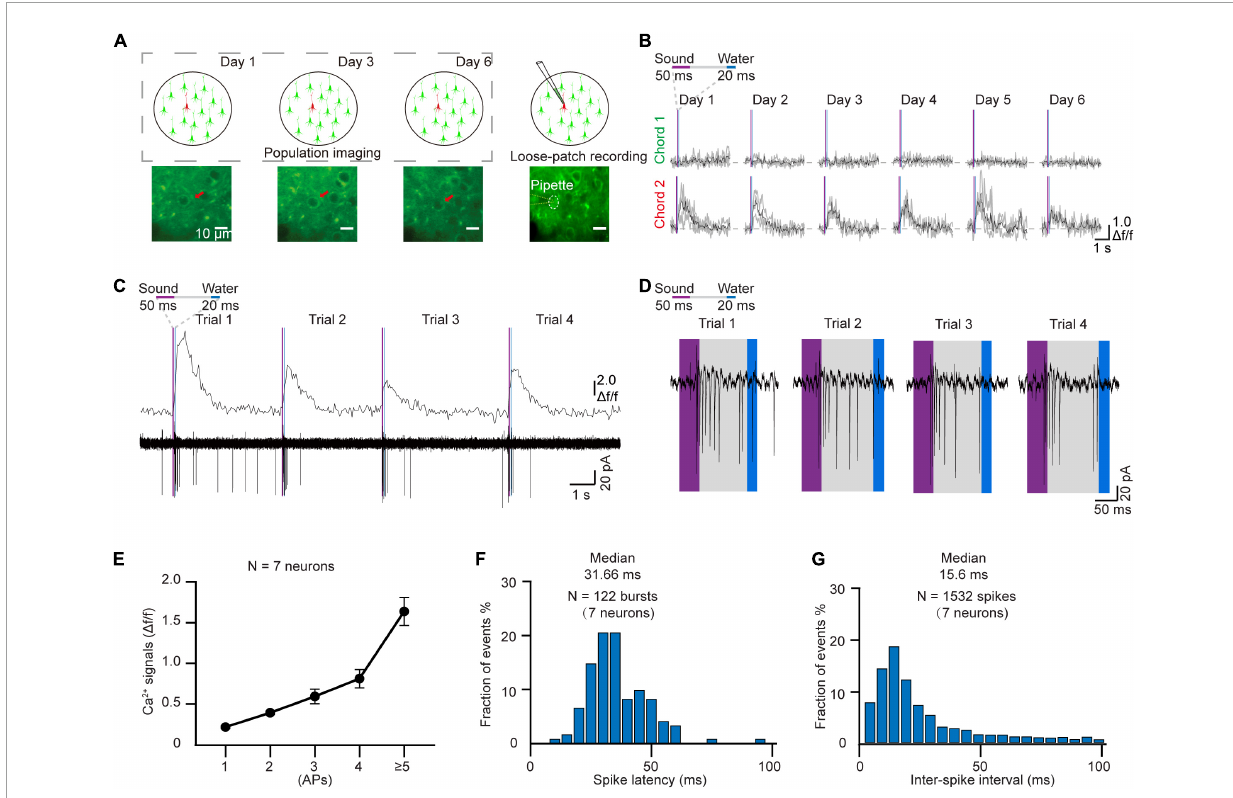
FIGURE4 Loose-patch recording after daily two-photon chronic imaging. (A) Schematic diagram of loose-patch recording after daily two-photon imaging on the AuC. (B) Ca 2 + signals responded to two chords during chronic two-photon imaging (Red arrow marked in panel A ). (C) 4 Consecutive trials of Ca 2 + signals and corresponding loose-patch responses of targeted neurons (Tracked by chronic imaging in panel B ) in the AuC of the behaving mouse. (D) Magnified view of the action potential (AP) in panel (C) . (E) Correlation of the different numbers of action potentials and their corresponding amplitudes of Ca 2 + transients (97 trials of 7 neurons from 5 mice). (F) Spike latency histogram for all the response events (122 burst events of 7 neurons). (G) Inter-spike interval histogram for all the response events (1532 spikes of 7